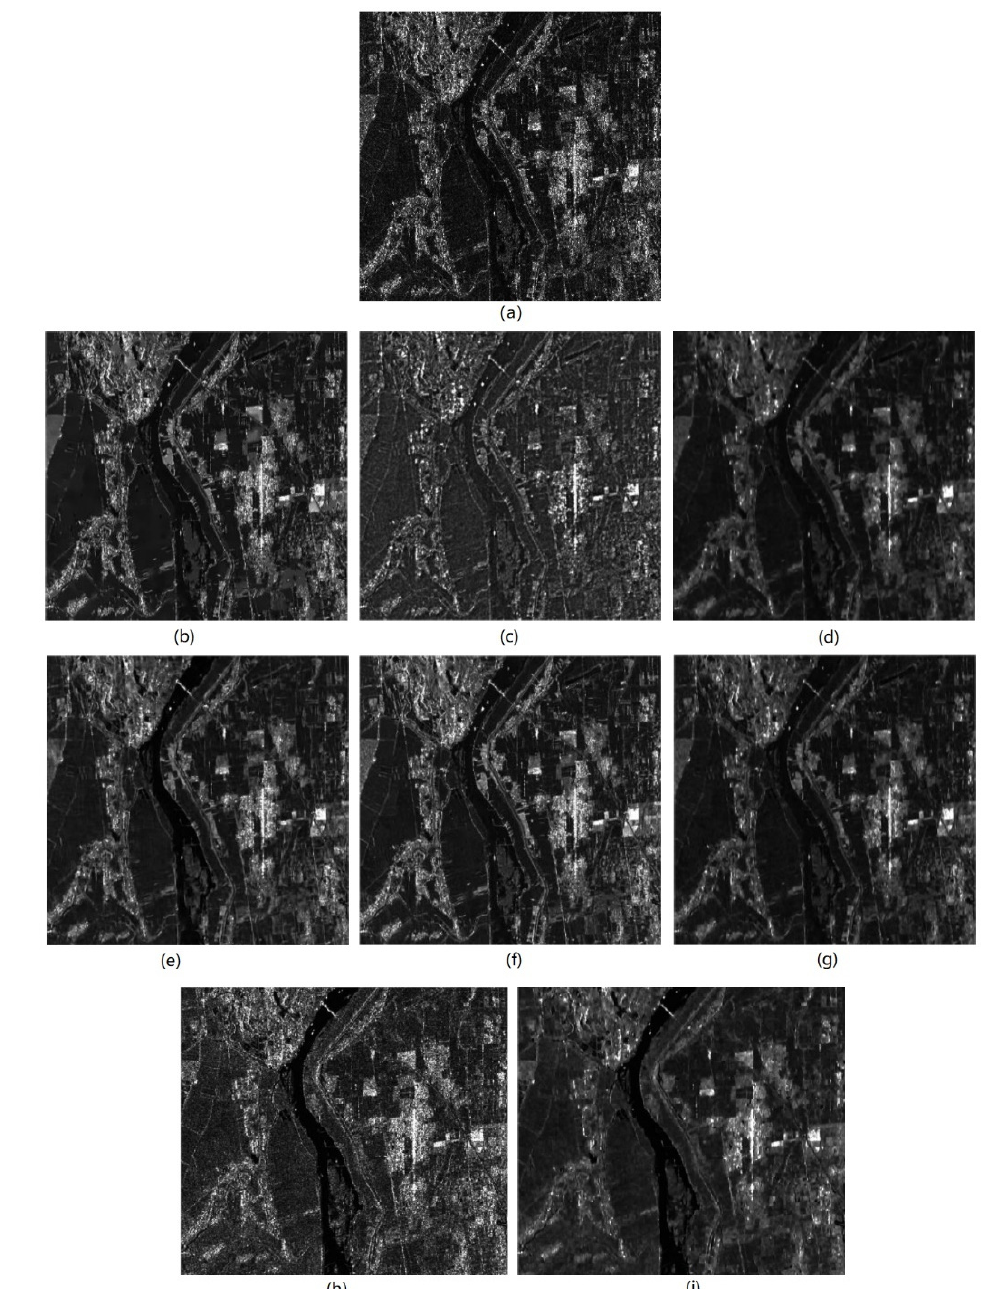
Figure 6. The despeckling result of the Sentinel-1 dataset. ( a ) Speckled image. ( b – g ) The images filtered by the PPB filter, the SAR-DRN filter, the BM-NR-DL filter trained with one image, the NR-SAR-DL filter, the MSAR-BM3D filter, and the BM-NR-DL filter trained with bi-temporal images, respectively. ( h ) Speckled image of a same region but another time phase. ( i ) The image filtered by the BM-NR-DL filter pre-trained with bi-temporal images.